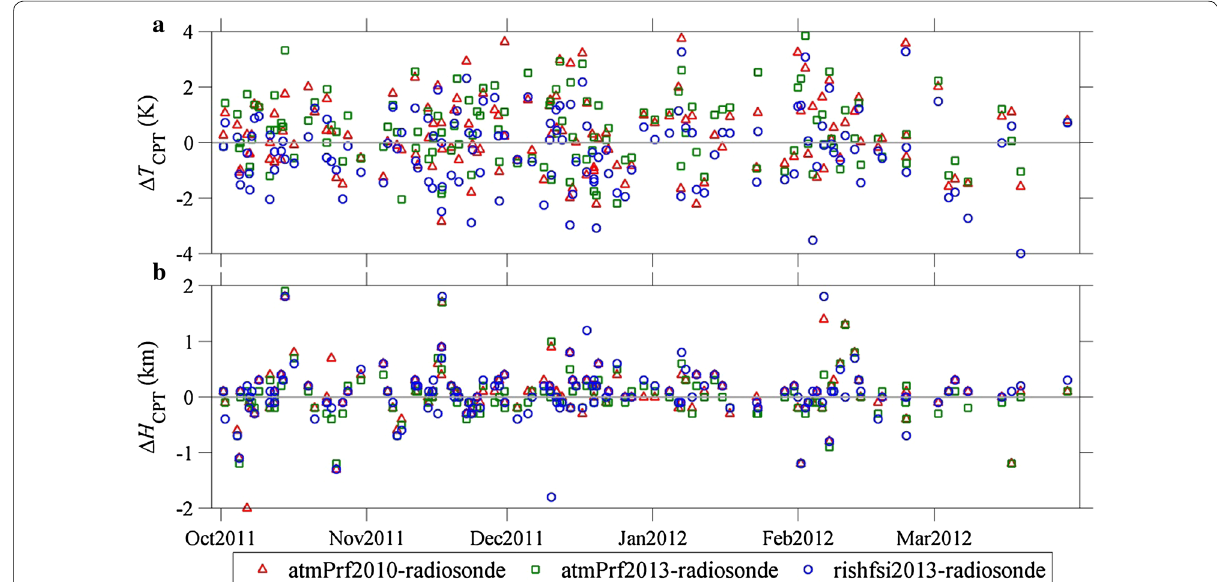
Fig. 8 Individual comparisons between COSMIC GPS-RO and a radiosonde for a ∆ T CPT and b ∆ H CPT . Tick marks on the horizontal axis indicate the first day of the corresponding month